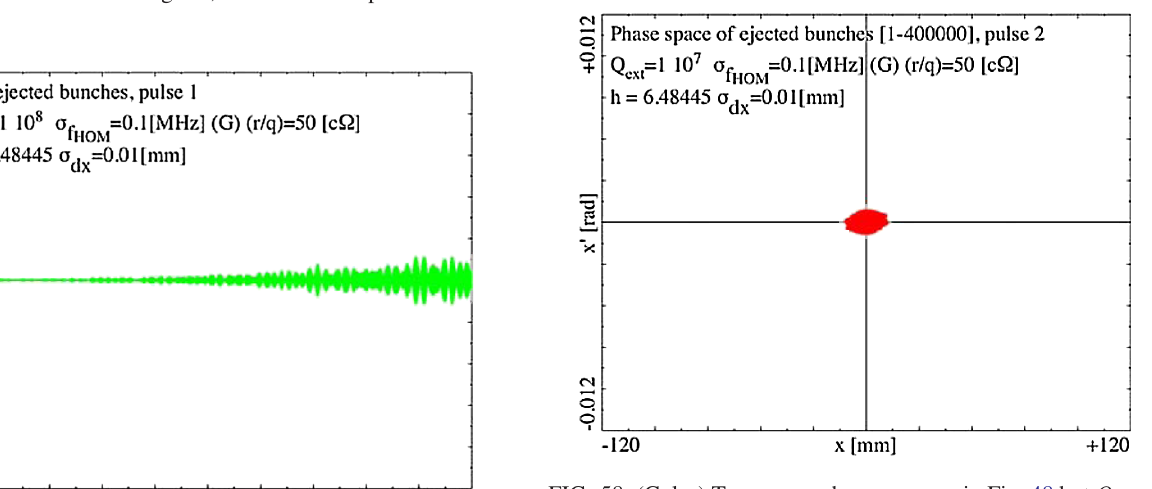
FIG. 58. (Color) Transverse phase space as in Fig. 48 but Q ext ¼ 10 7 , 2nd pulse; for this Q ext the pulse-to-pulse coupling is